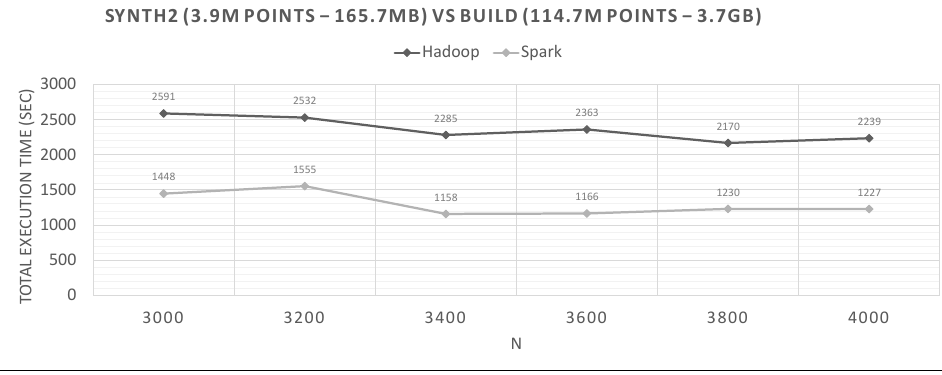
Figure 24. Hadoop vs. Spark, large synthetic query and medium training datasets.